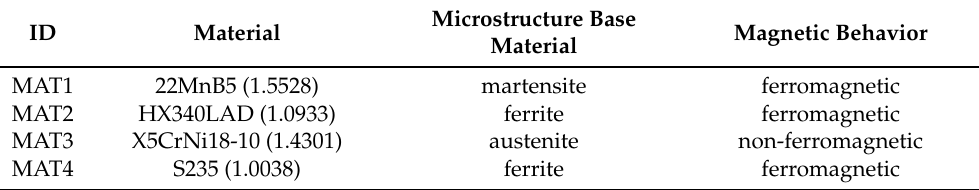
Table 1. Investigated materials with microstructure of the base material and magnetic behavior in the delivery